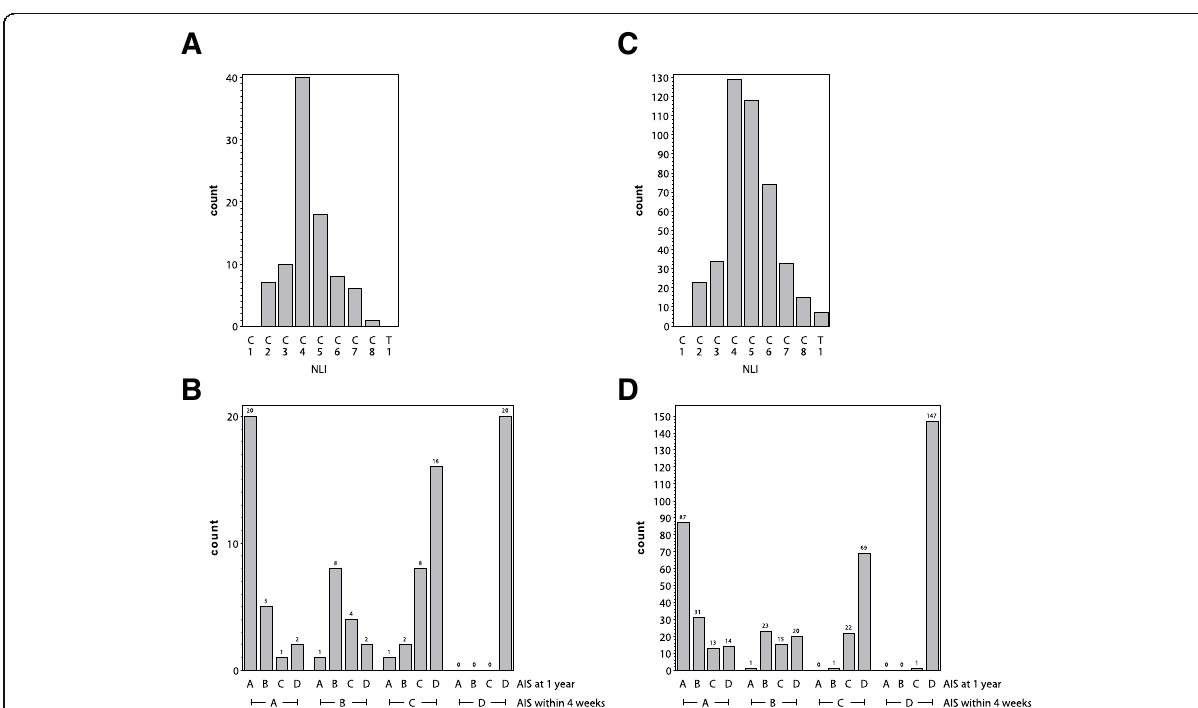
Fig. 1 a NLI distribution ( b ) AIS conversions of the EMSCI-HD cohort. c NLI distribution ( d ) AIS conversions of the EMSCI-nonHD cohort. Complete-case analysis: EMSCI-HD n = 90; EMSCI-nonHD n =